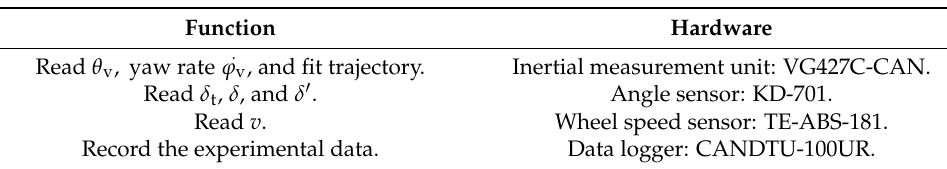
Table 2. Equipment list of the experiment.